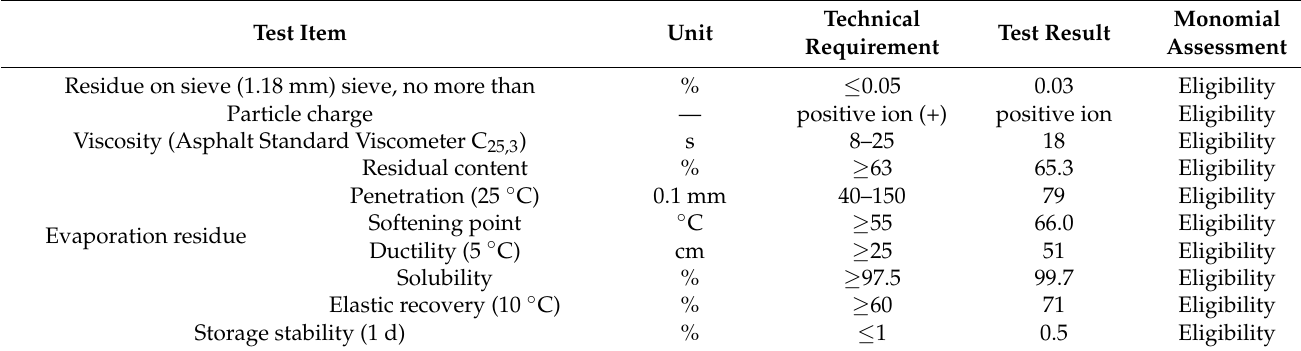
Table 5. The technical index of modified emulsified asphalt.